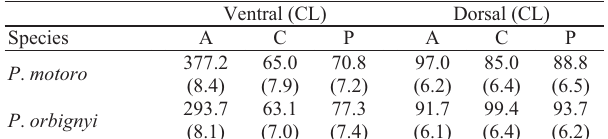
Table 3. Mean numbers of neuromasts and their density per centimeter of canal length (CL) in the three body sections (A = anterior, C = central, and P = posterior) on the ventral and dorsal surfaces in Potamotrygon motoro and P . orbignyi .